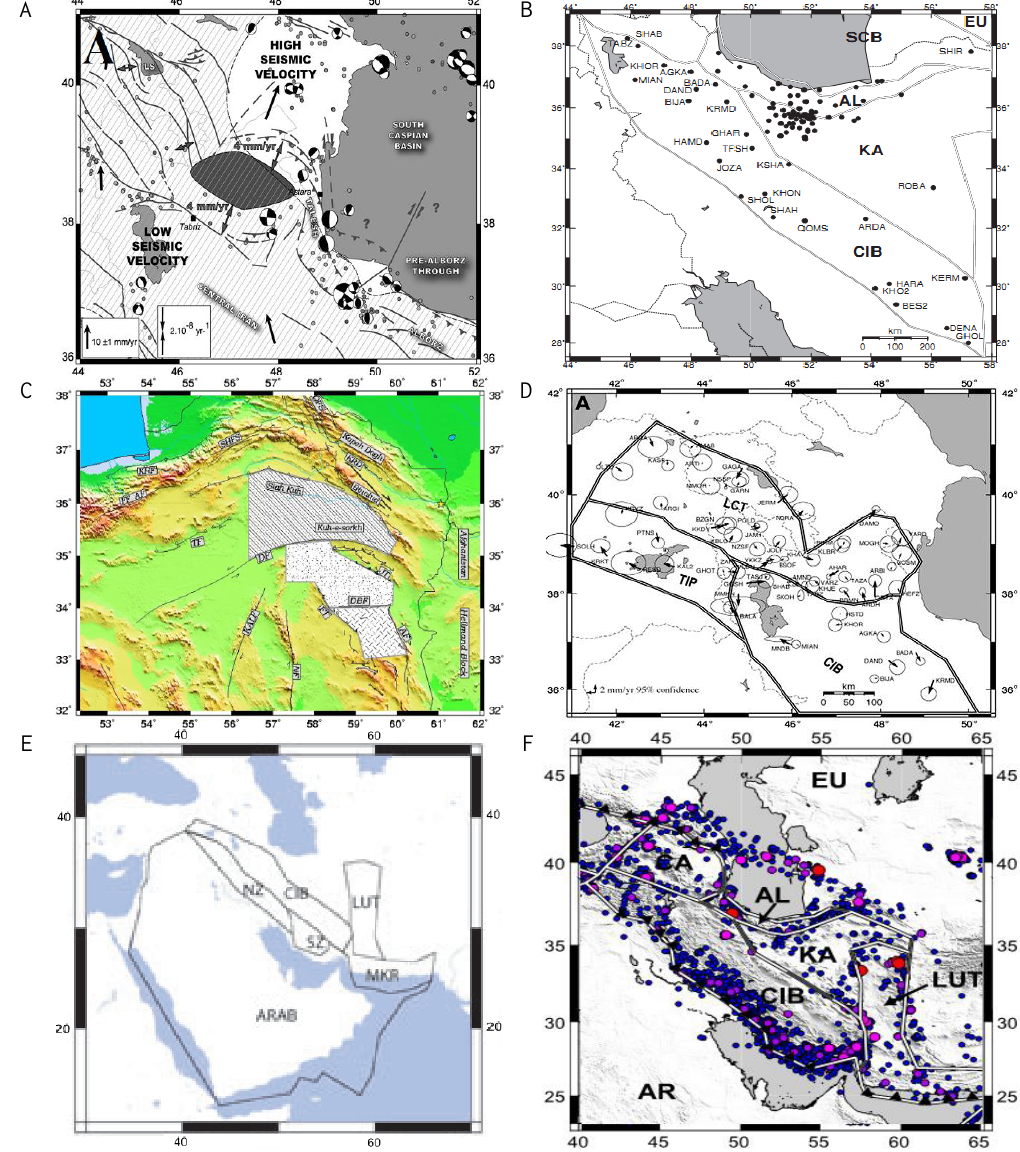
Figure 2. Some of the existing blocks in the region of Iran, the results of some deformation studies. A) Talesh block (Masson et al. 2006). B) Central Iranian block (Djamour et al. 2010). C) Three detected blocks in north-eastern part (Tavakoli 2007). D) North-western blocks (Djamour et al. 2011). E) Iranian blocks and Arabian main block (Peyret et al. 2009). F) Iranian blocks related to earthquake locations (Reilinger et al. 2006).